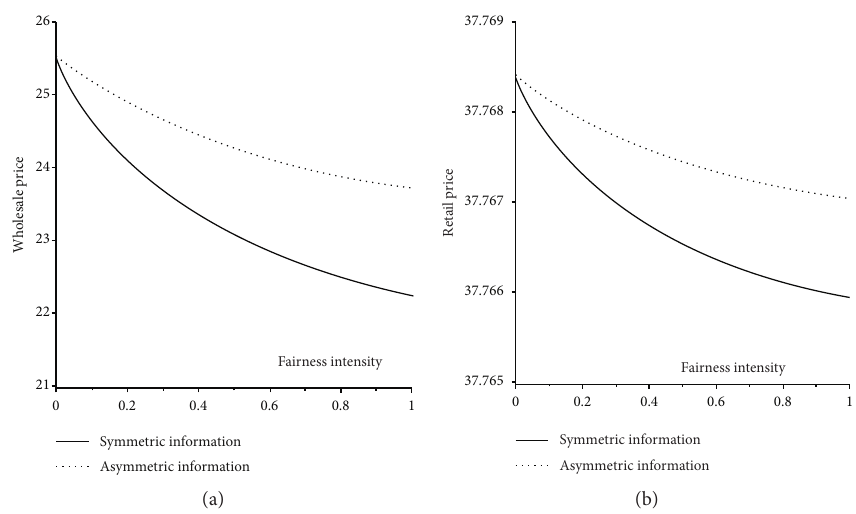
Figure 2: Sensitivity of price to fairness concerns. (a) Wholesale price. (b) Retail price.